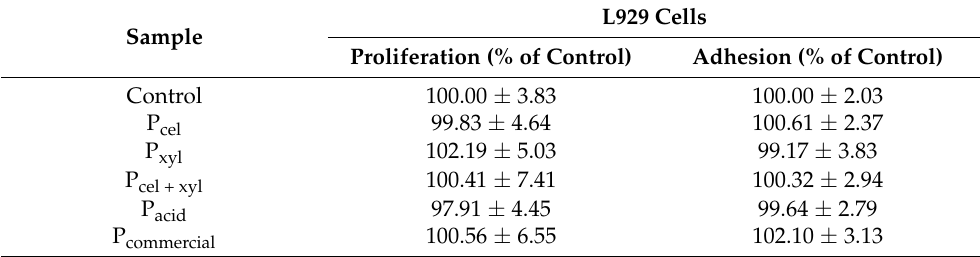
Table 4. The lack of effect of apple pectins on L929 cell proliferation and